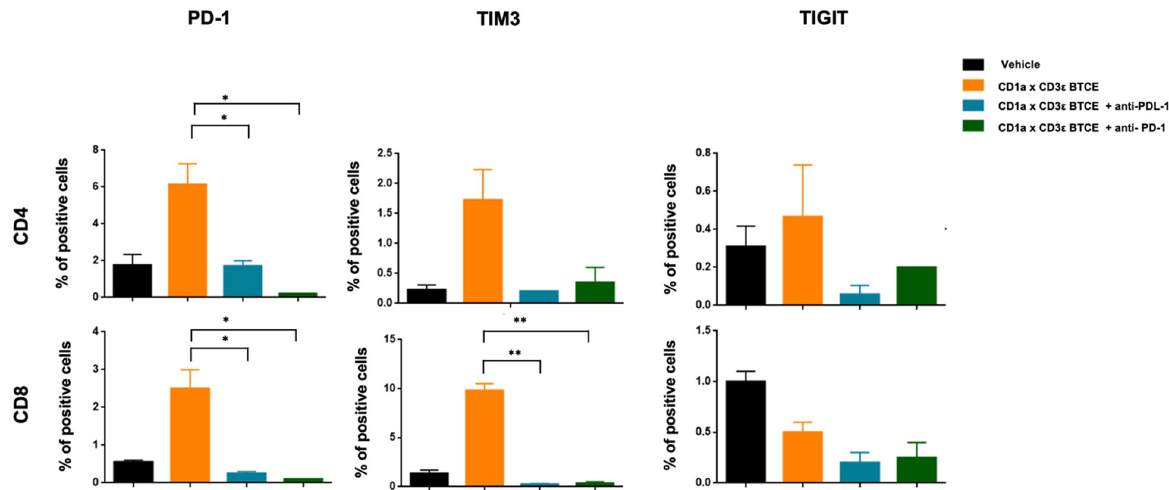
Figure 6. Immune checkpoint inhibitors and CD1a x CD3 ε combinatorial approach. Expression of exhaustion markers (PD-1, TIM-3, LAG-3, and TIGIT) on CD4+ and CD8+ T-lymphocytes co-cultured with Jurkat cell line in the presence of CD1a x CD3 alone, CD1a x CD3 ε plus anti-PD-1, or anti PD-L1. * p < 0.05, ** p < 0.01.